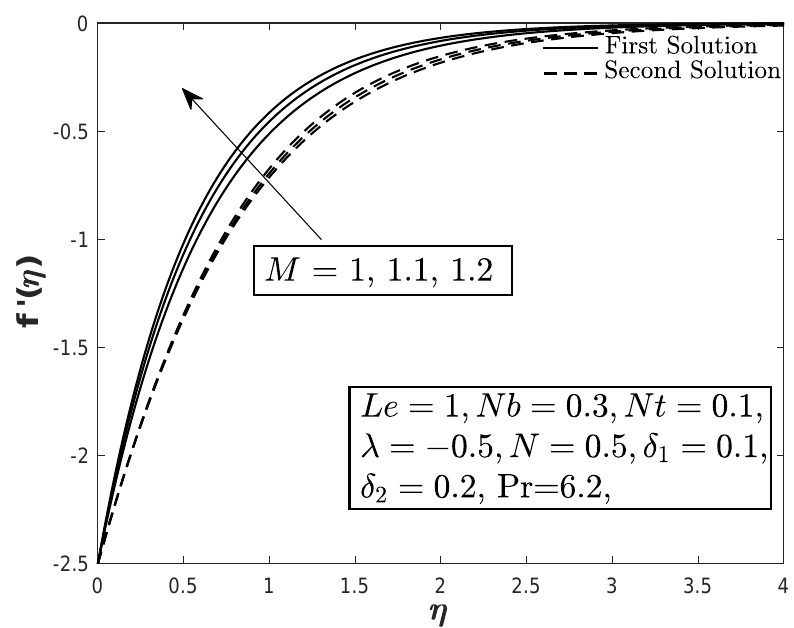
Figure 12. Effect of magnetic parameter M on the velocity profile.